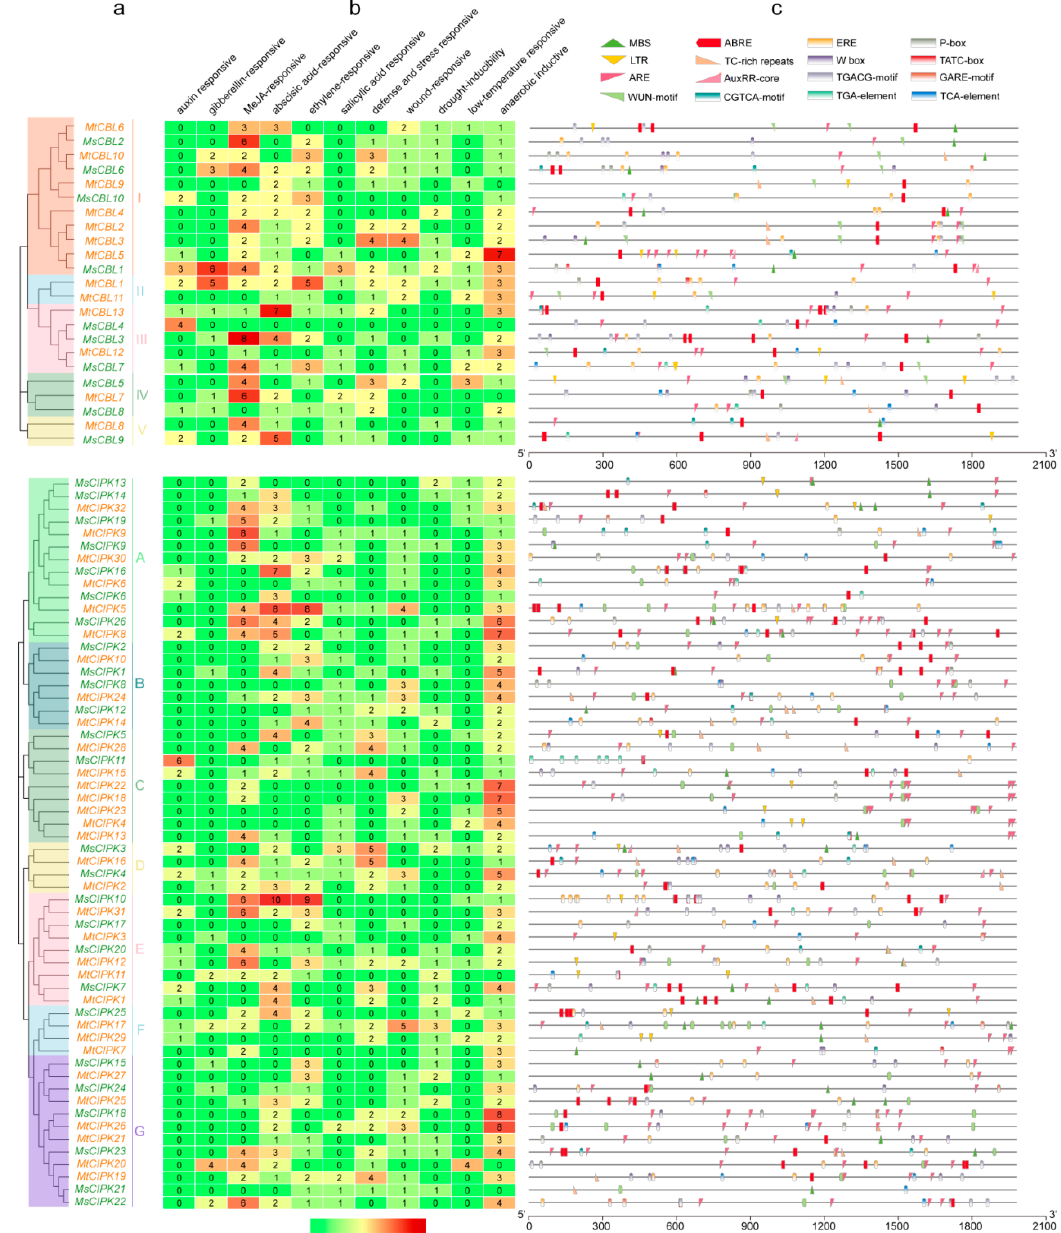
Figure 4. Putative cis-elements and transcription factor binding sites in the promoter regions of CBL and CIPK genes from M. sativa and M. truncatula . ( a ) The groups and color are indicated as in Figure 1. ( b ) The colors and numbers of the grid indicated the numbers of different cis -acting elements in these CBL and CIPK genes. ( c ) The colored block represented different types of cis -acting elements and their locations in each CBL and CIPK gene.